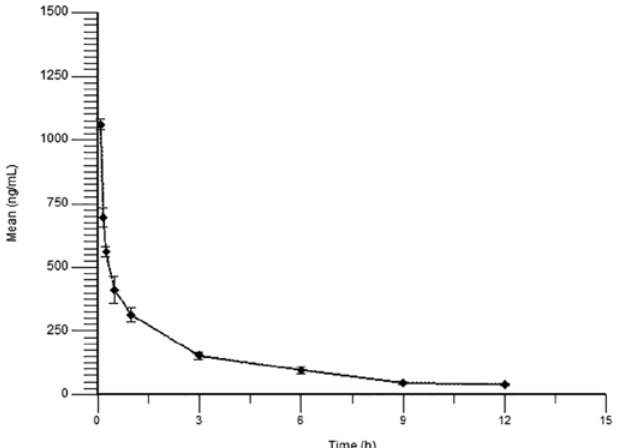
FIGURE 2 - Mean plasma concentration-time profile of RH after intravenous administration of 5 mg.kg -1 drug. Data are expressed as mean ± SD